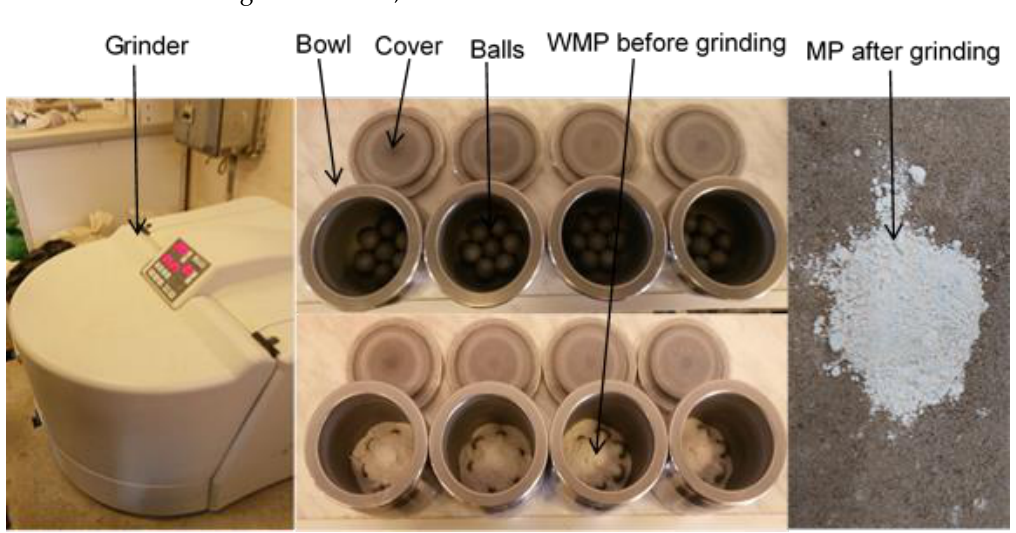
Figure 3. Grinding process of marble powder (MP) using grinder FRITSCH PLANETARY MILLS classic line with its constituents.